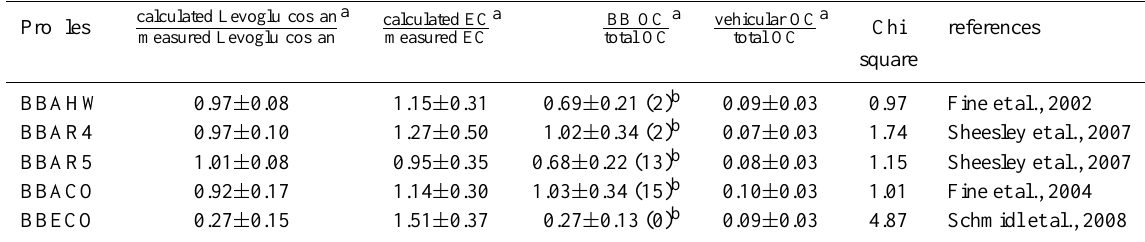
Table 2. Selected CMB results obtained using the five selected biomass burning (BB) profiles.